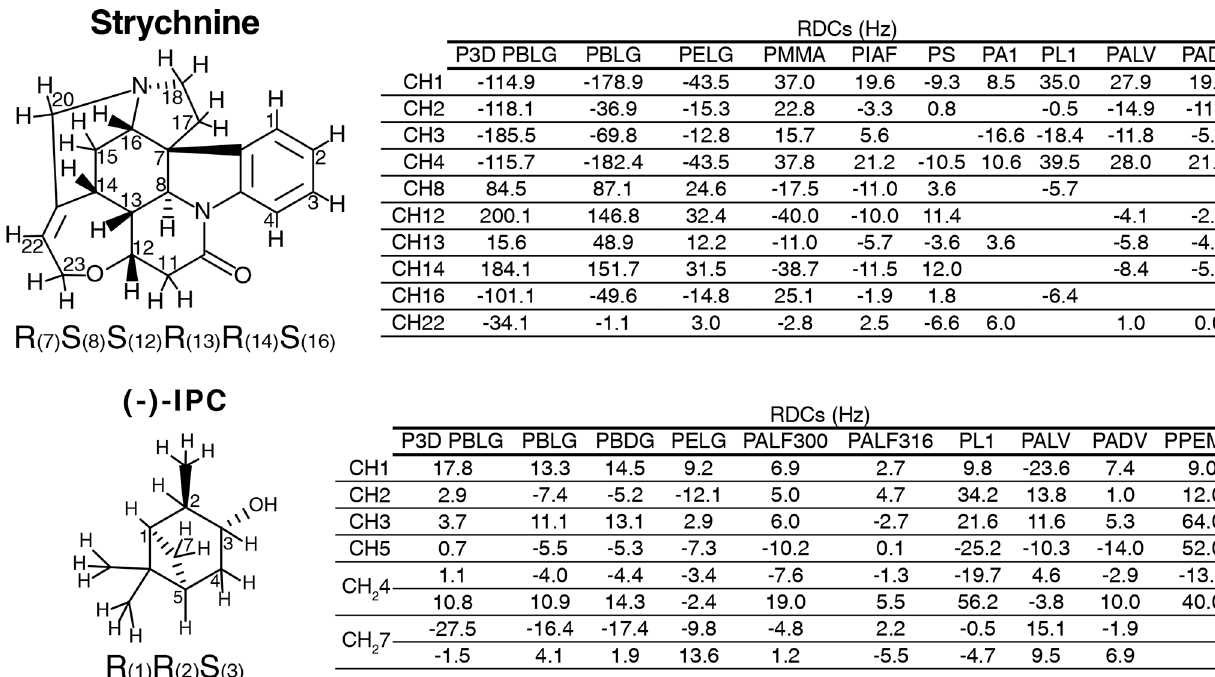
Figure 2. Strychnine and ( − )-IPC structures together with the CH carbon labels and the correct configuration (left), as well as the respective lists of RDCs in the different alignment media